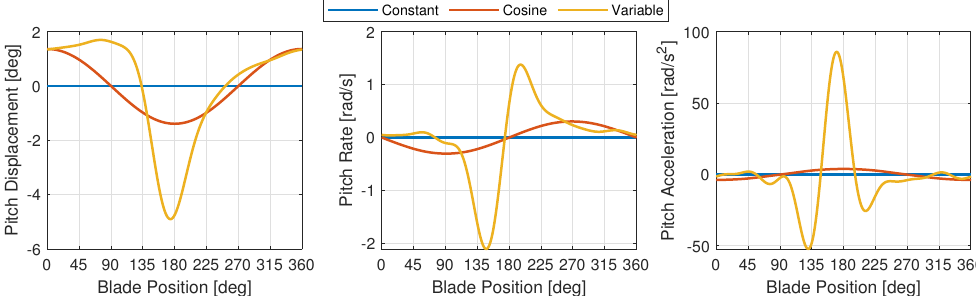
Figure 6. Pitch displacement, pitch rate and pitch acceleration of the pitch trajectories determined in